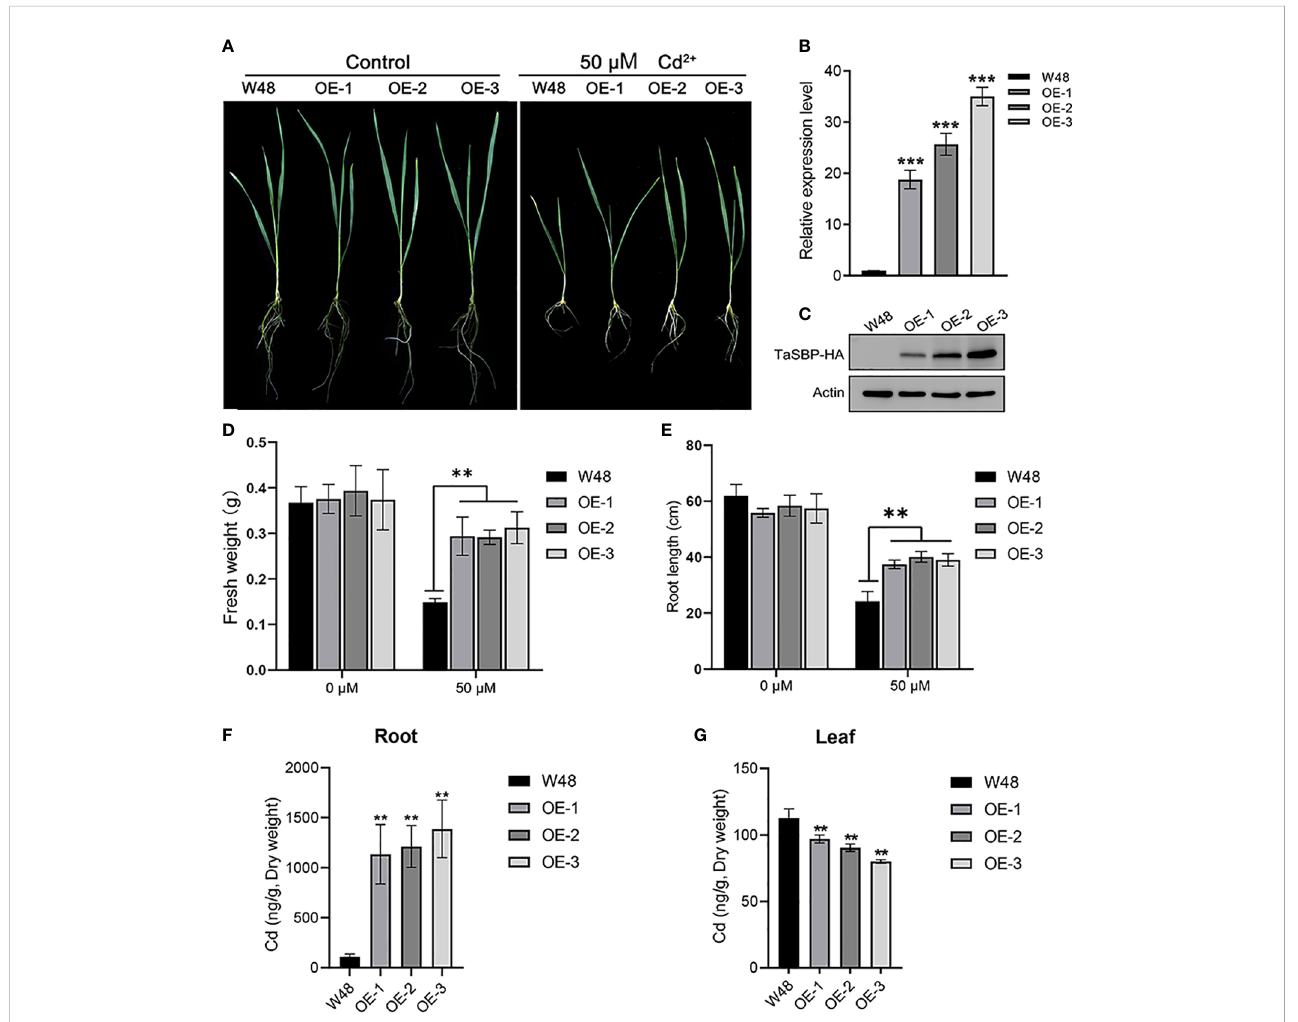
FIGURE 5 Overexpression of TaSBP-A enhanced wheat tolerance to Cd stress. (A) Seedlings of W48 and three TaSBP-A overexpressed lines (OE-1, OE-2 and OE-3) under 50 m M Cd 2+ treatment for two weeks. (B) The expression levels of TaSBP-A relative to the internal control UBI gene in W48, OE-1, OE-2 and OE-3 determined by RT-qPCR. (C) The protein level of TaSBP-A-HA in leaf of W48 and TaSBP-A overexpressed wheat seedlings were validated using Western blot. (D) The fresh weight of plants under Cd stress. (E) The root length of plants under Cd stress. (F) The content of Cd in plant roots under 50 m M Cd 2+ treatment for two weeks. (G) The content of Cd in plant leaves under 50 m M Cd 2+ treatment for two weeks. The data are shown in mean values ± Sd. One- way ANOVA was used for statistical analysis of all data. The asterisks represent signi fi cant differences at different levels (** p < 0.01, *** p <